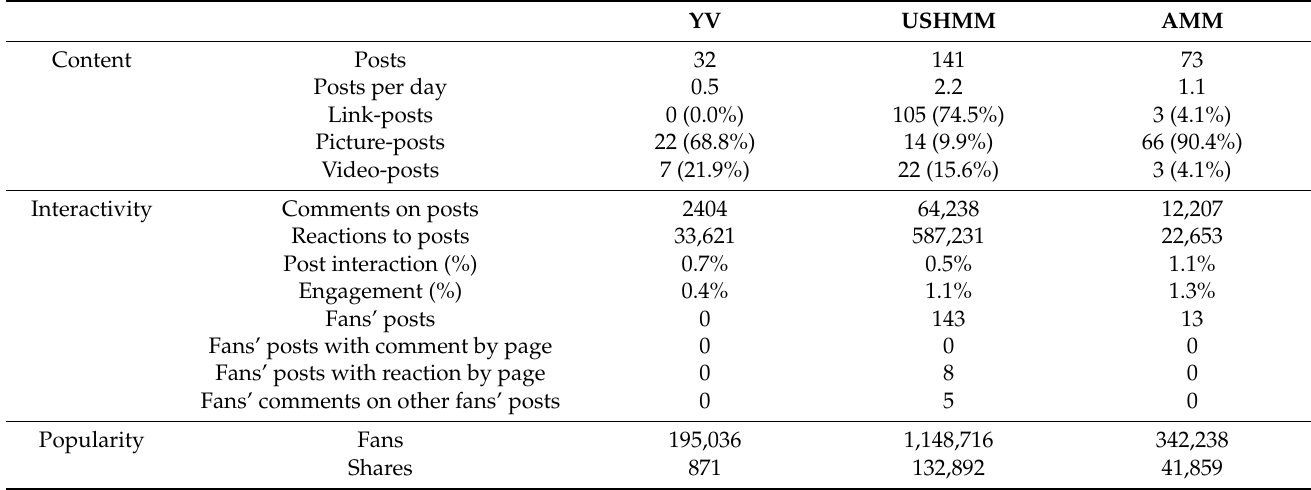
Table 4. Content, interactivity, and popularity of museums’ Facebook pages.